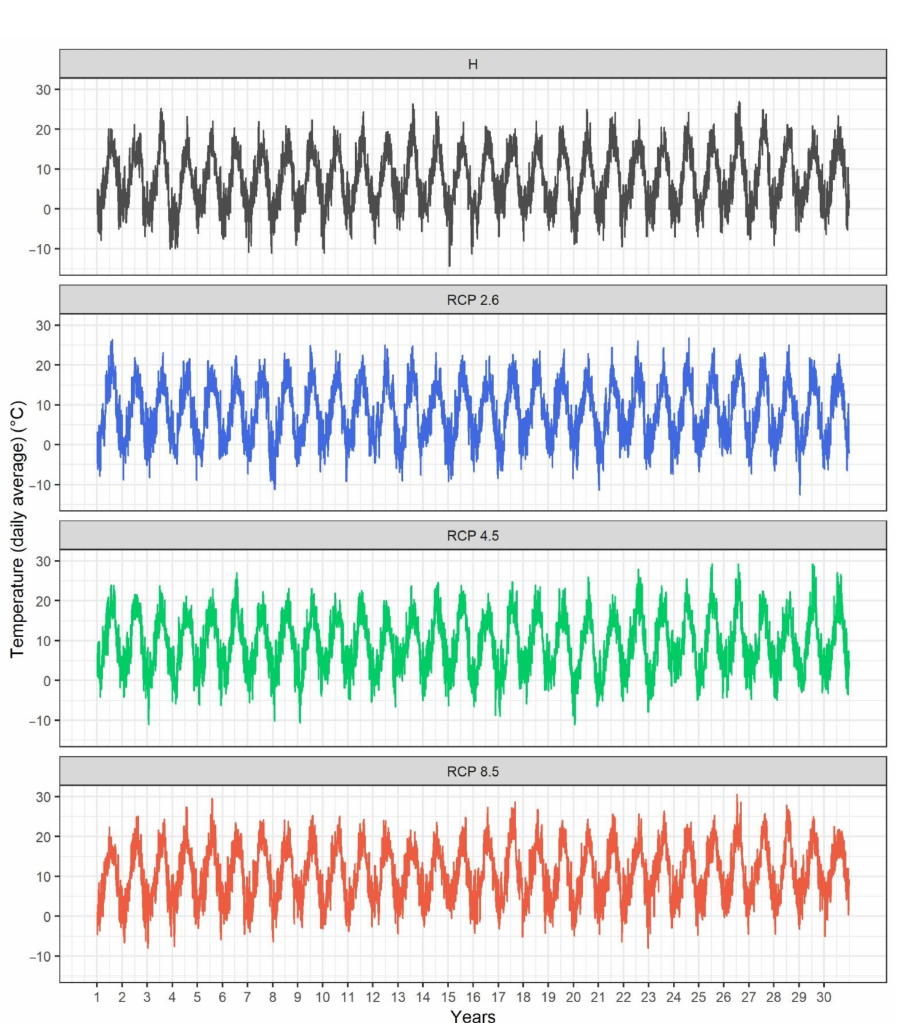
Figure A1. Daily average temperature series for the historical period (H) and three RCP